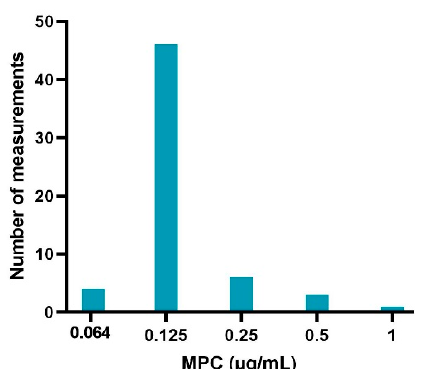
Figure 2. Enrofloxacin MPC distribution of 20 sensitive avian pathogenic Escherichia coli (APEC) strains obtained via agar dilution experiments, performed in triplicate (60 measurements in total). Table 1. Summary of the mutant prevention concentration (MPC) values of 20 selected sensitive avian pathogenic Escherichia coli (APEC) strains obtained via agar dilution experiments performed in triplicate. The width of the mutant selection window (MSW), indicated by the MPC over the MIC ratio, is given between brackets next to the MPC values. Table 2. Overview of the fluoroquinolone resistance mechanisms (QRDR and PMQR) of the di ff erent NWT strains (strains with MIC values above the ECOFF). QRDR Mutations MIC ( µ g / mL) Number of Isolates PMQR gyrA parC parE 0.25